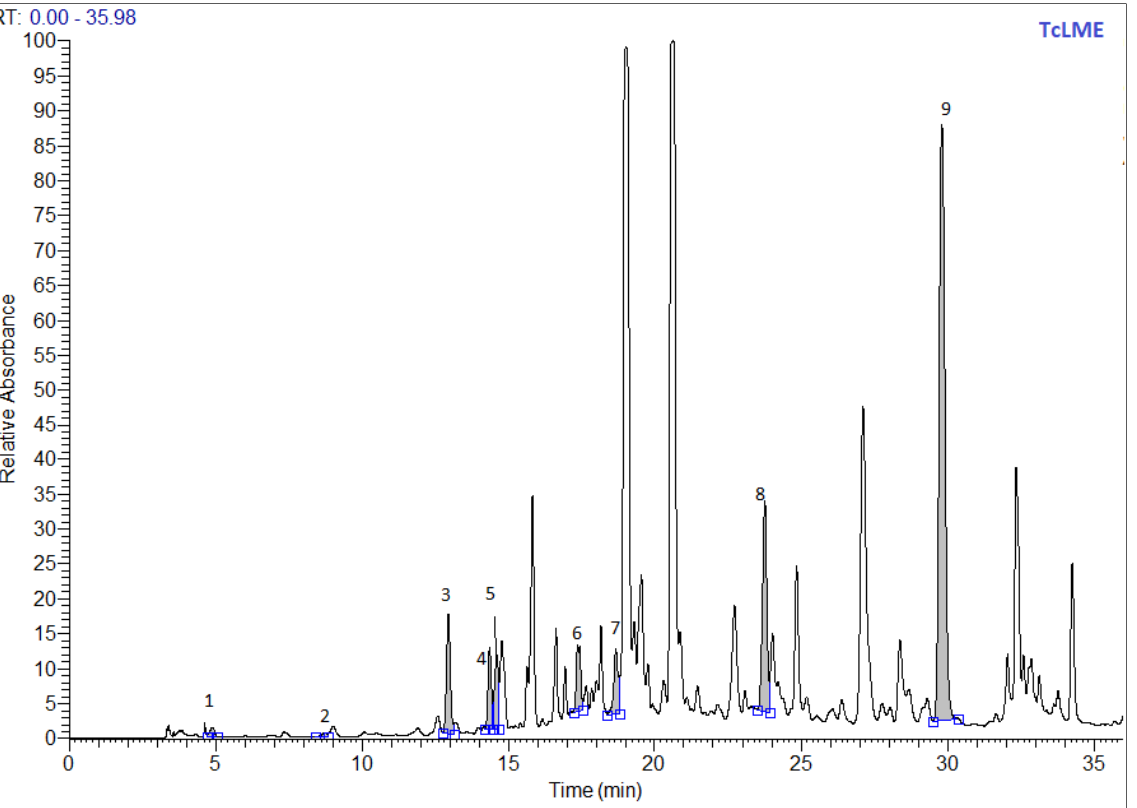
Figure 1. LC–MS chromatogram of phenolic compounds in the methanolic extracts of Thymus Figure capitatus leaves, as detected at 280 nm.